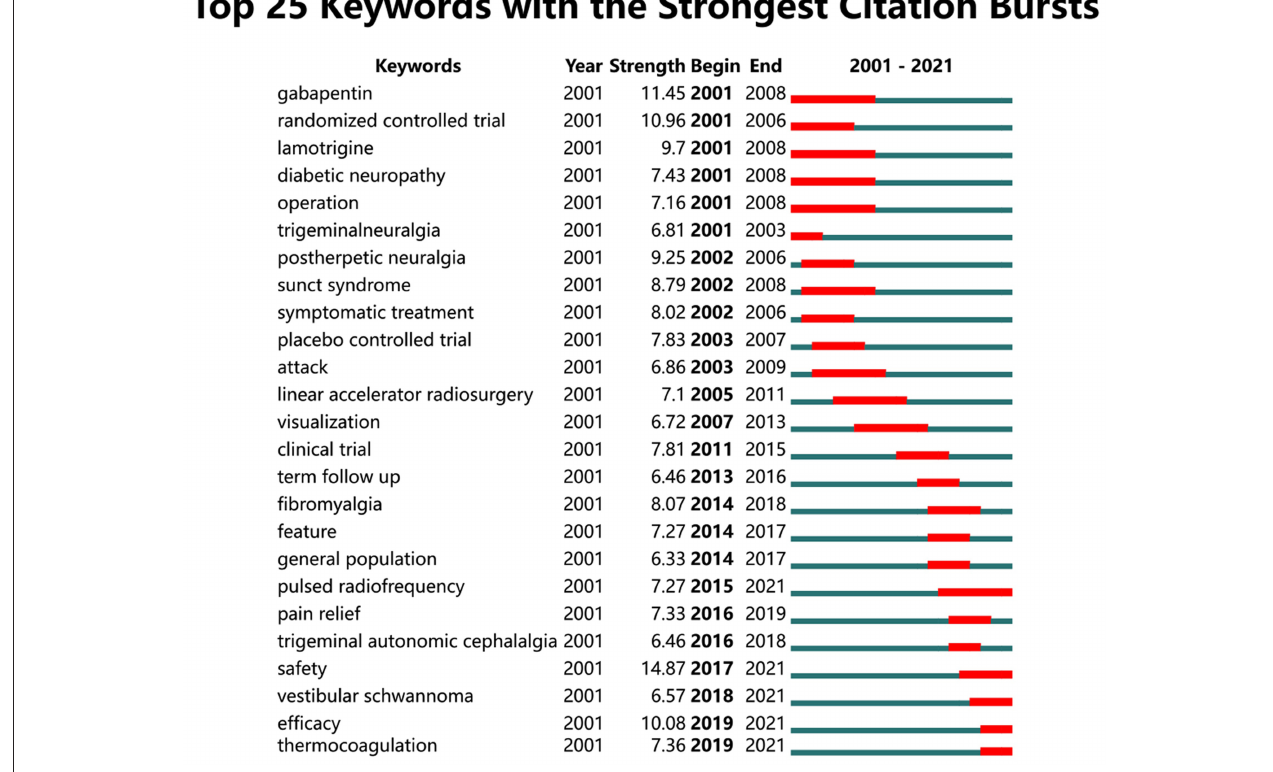
FIGURE 6 | The top 25 keywords with the strongest citation bursts on TN research from 2001 to